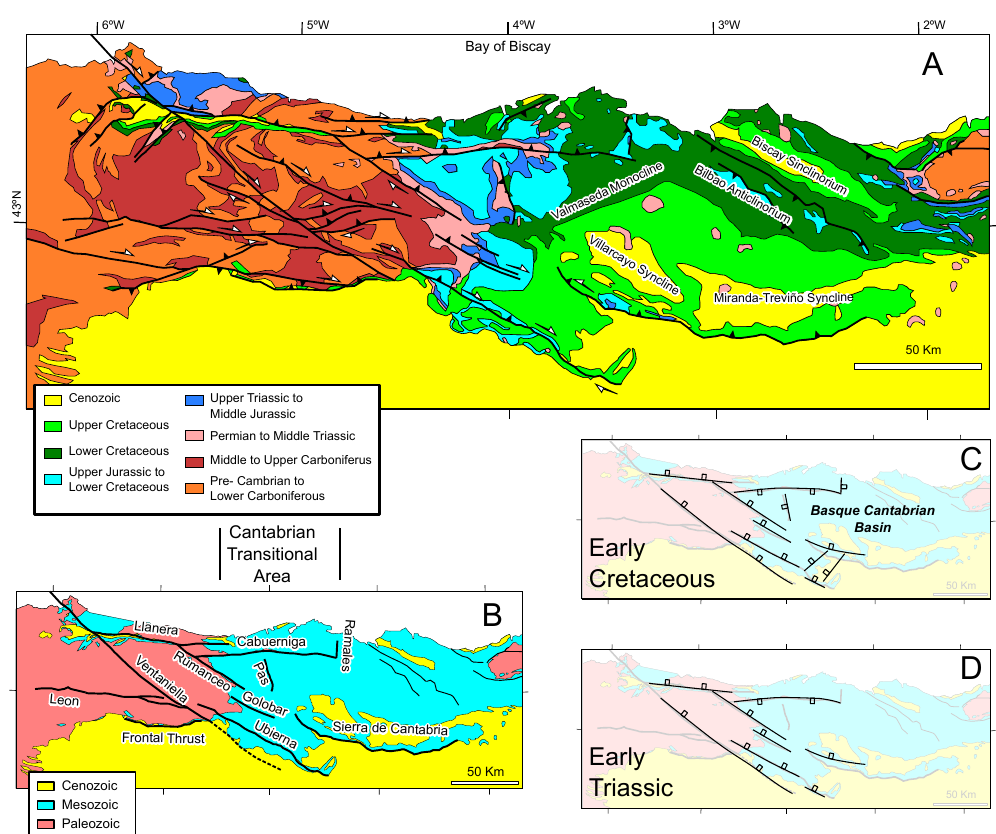
Fig. 3. (A) Geological map of the Cantabrian Transitional Area and surrounding areas (after Tavani et al., 2011a). (B) Labelling of major faults. Reconstruction of fault patterns at the end of Early Cretaceous (C) and Early Triassic (D) (modified from Tavani and Mu˜noz, 2012 and Quint`a and Tavani,